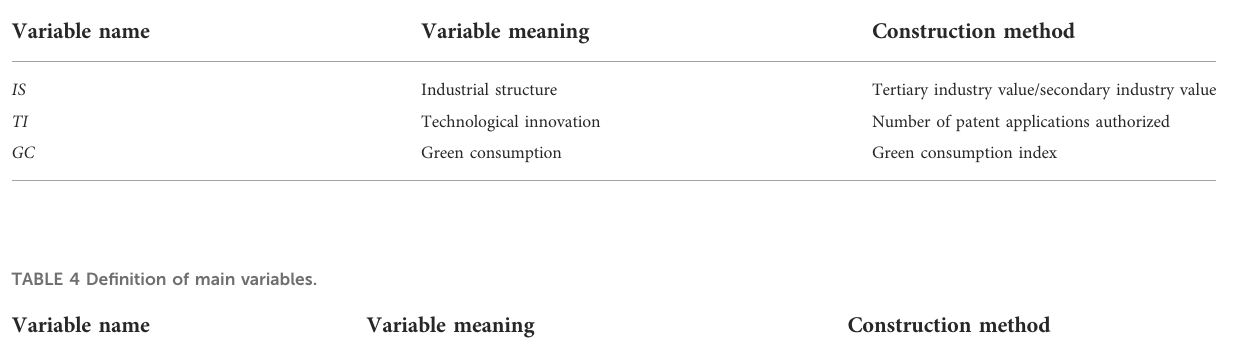
TABLE 3 De fi nition of intermediary variables.